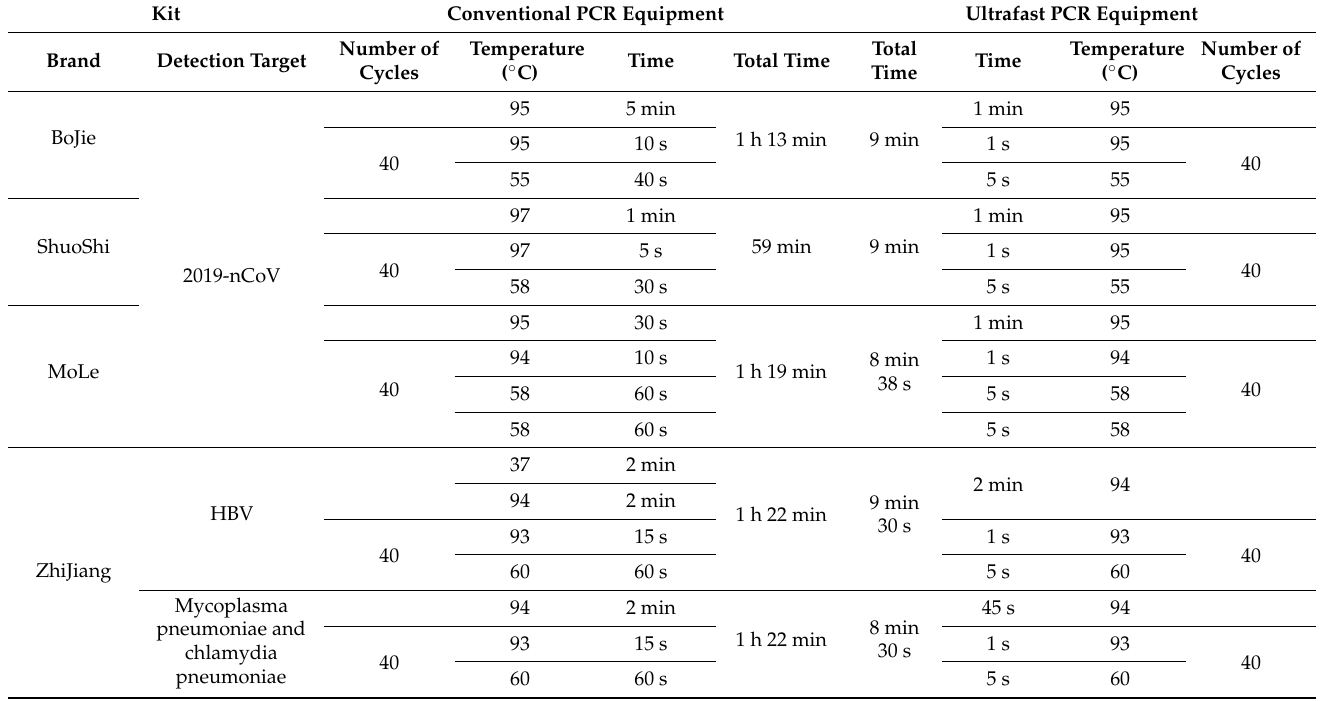
Table A2. Variable temperature parameters and results of accelerated test of PCR detection